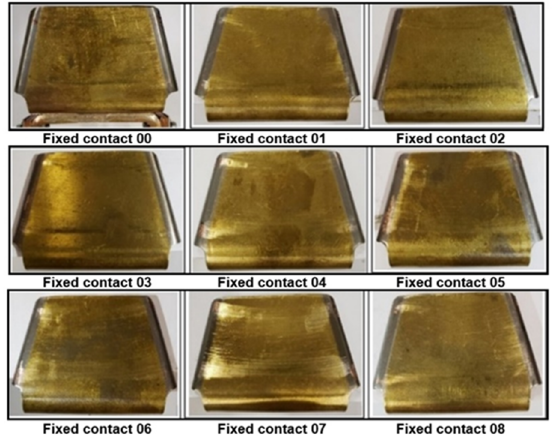
Figure 10. Fixed contacts after removal of the voltage regulator from operation.